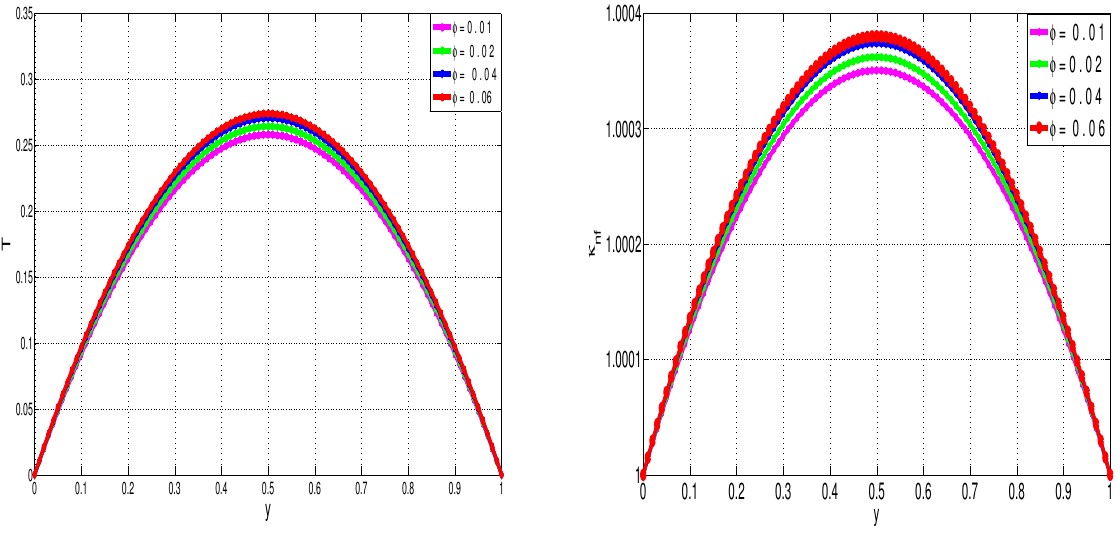
Figure 15. Sensitivity of VFBN temperature ( left ) and thermal-conductivity ( right ) to variations in φ